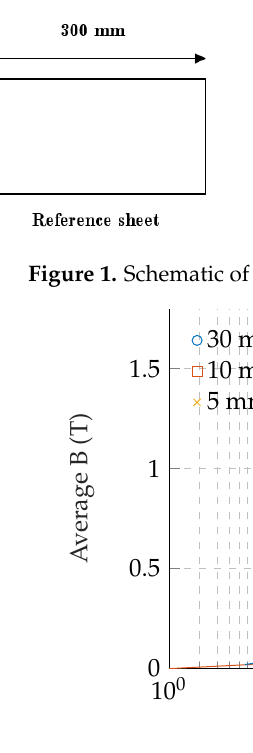
Figure 2. Magnetization curves at 60 Hz for different sample widths. The resulted fitting curves are given with the measured results denoted by